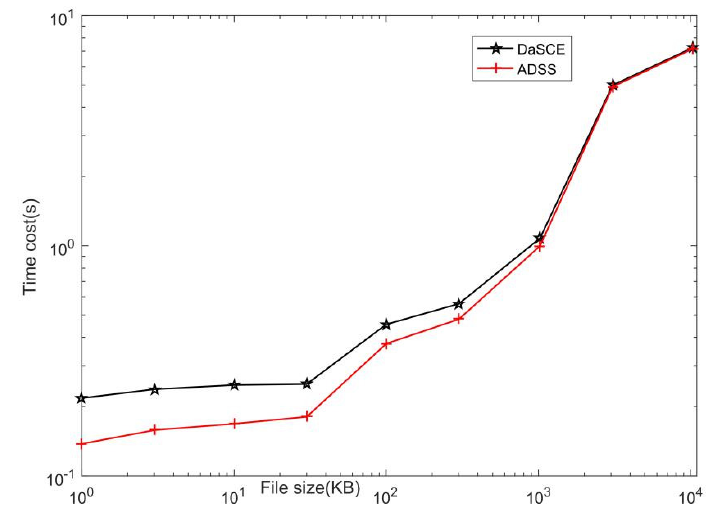
Figure 10. Comparison of file upload times in two protocols.